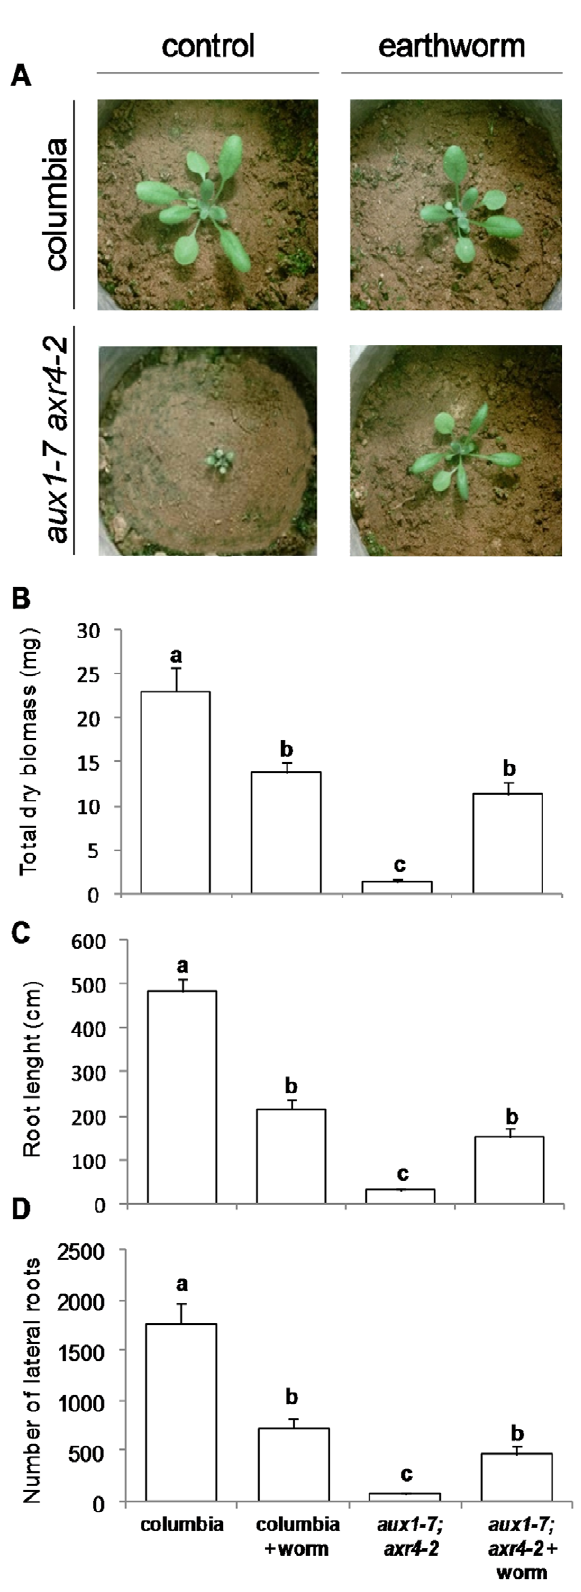
Figure 2. Effects of Apporectodeacaliginosa on the growth of Arabidopsisthaliana cv. Columbia and aux1-7;axr4-2 mutant. (A) Picture of Arabidospis thaliana at three weeks after sowing. Effect of the presence of Aporrectodea caliginosa on (B) total biomass production,